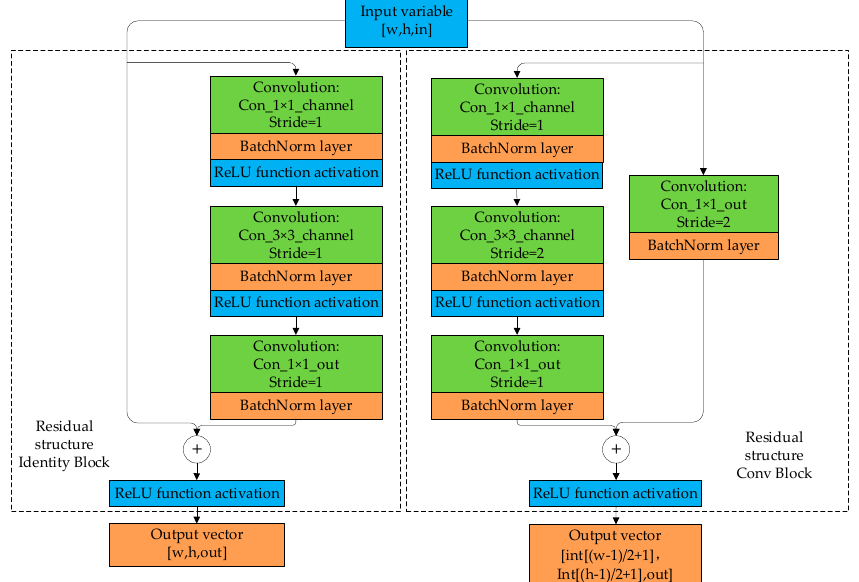
Figure 6. Identity block and Conv block residual